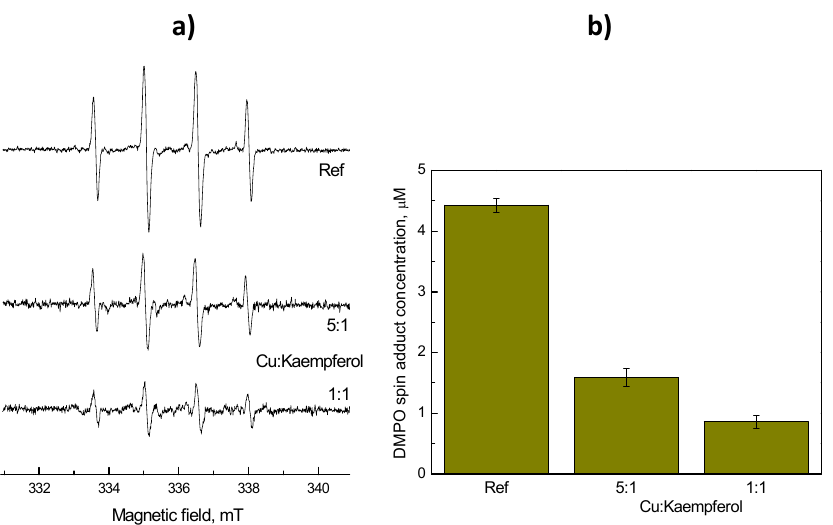
Figure 5. The effect of Kaempferol, present in two different Cu–Kaempferol molar ratios (5:1 and 1:1), on the formation of free radicals by means of a copper-catalyzed Fenton reaction. ( a ) Experimental EPR spectra obtained in the system CuCl 2 /H 2 O 2 /DMPO/DMSO–H 2 O (1:4; v:v) under an air atmosphere, without (Ref) or with Kaempferol. ( b ) The total concentration of DMPO spin adduct concentration monitored in DMSO/water (1:4; v:v) solution of CuCl 2 alone (Ref) or in the presence of Kaempferol containing DMPO spin trapping agent after the addition of hydrogen peroxide. Initial concentrations: c (CuCl 2 ) = 0.2 mM; c (Kaempferol) = 0/0.04/0.2 mM; c (DMPO) = 0.02 M; c (H 2 O 2 ) = 0.01 M. EPR parameters: DMPO ‐ OH ( a N = 1.486 mT, a H β = 1.438 mT; g = 2.0057); DMPO ‐ O 2– ( a N =